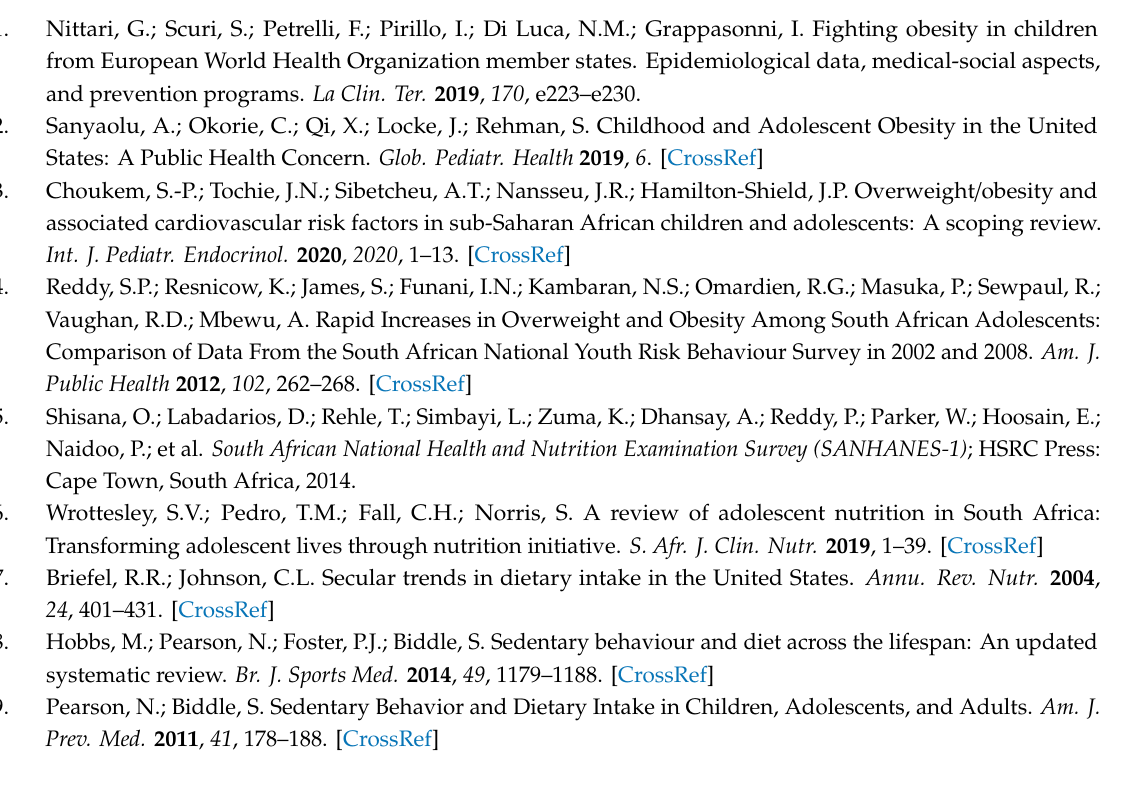
Table S1: Dietary practices associated with body weight status of secondary school adolescents in the Eastern